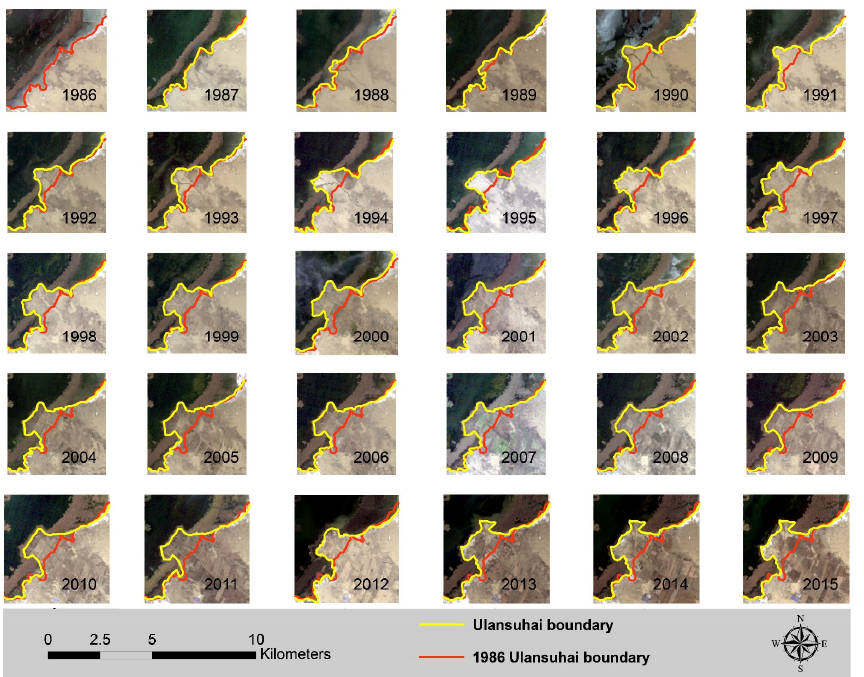
Figure 5. Annual changes of Lake Ulansuhai boundaries, partly due to siltation caused by soil erosion in the HTYZ